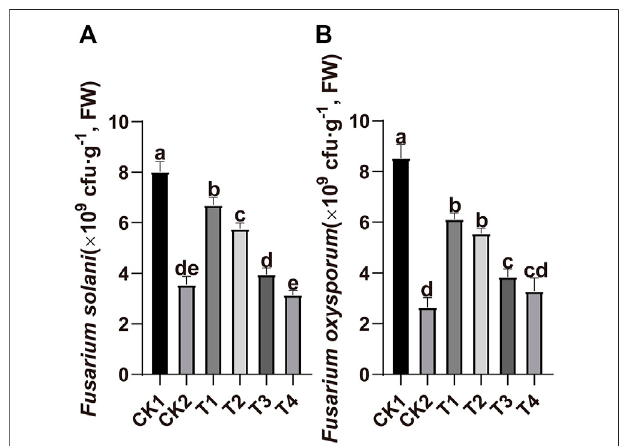
FIGURE 2 | Effects of different treatment on the gene copy number of F. solani and F. oxysporum in replant soil. (A) F. solani and (B) F. oxysporum . CK1: control, CK2: highstandardcontrol, T1:foliar spraying, T2:foliar soaking, T3: root soaking, T4: soil soaking. The different letters above the bar indicate that there is a signi fi cant difference between the mean values of different treatments using one-way ANOVA and Duncan ’ s multiple range test ( p < 0.05). Error bars indicate ± S.E. ( n =